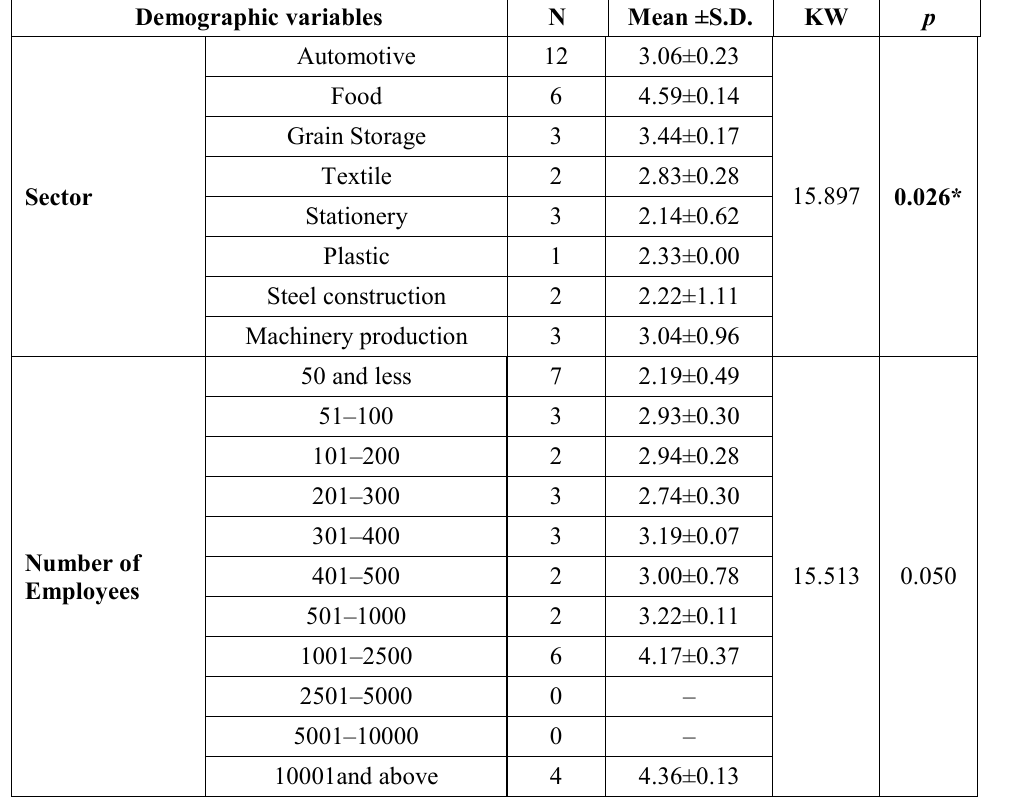
Table 3. Research Analysis Results of Kruskal H Test for Demographic Characteristics of the Enterprise Related to the Level of Education